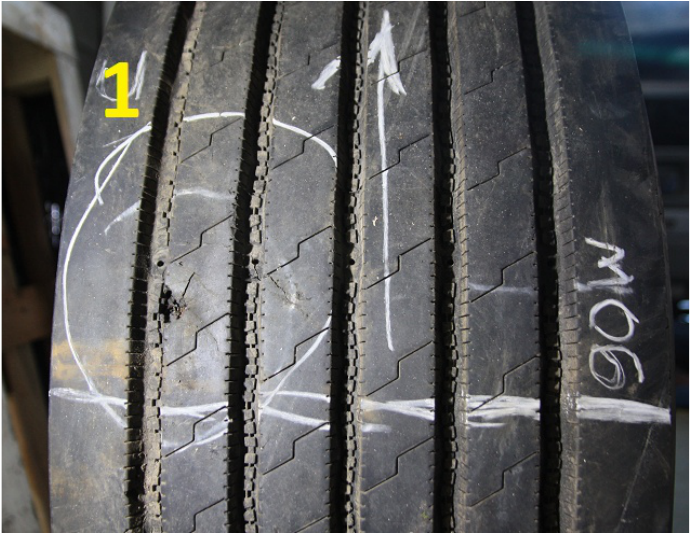
Figure 7. Local deformation of the sidewall on the inner side (indicated by an arrow).